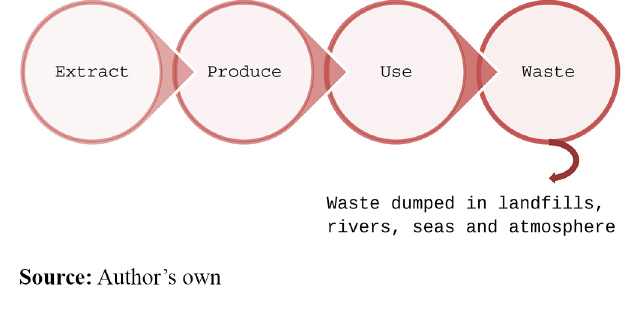
Figure 4. Linear economy paradigm